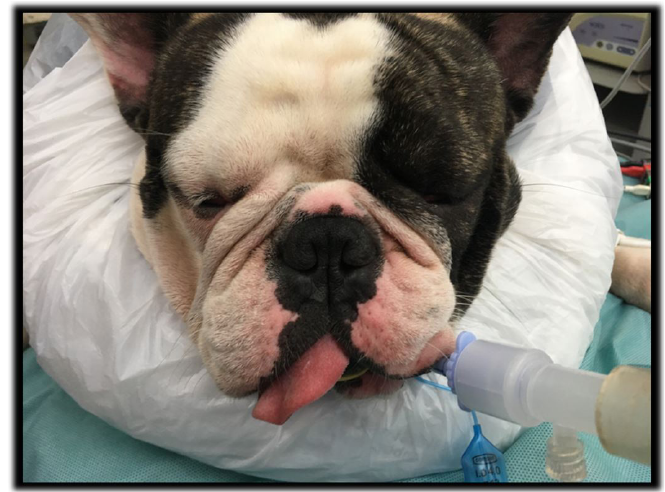
Figure 1. Anesthetized patient, positioned in prone position, showing nostril stenosis, moments before the rhinoplasty surgical procedure (Source: Personal